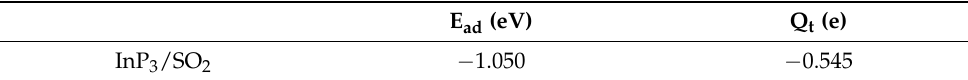
Table 3. Parameters of SO 2 adsorption by intrinsic InP 3